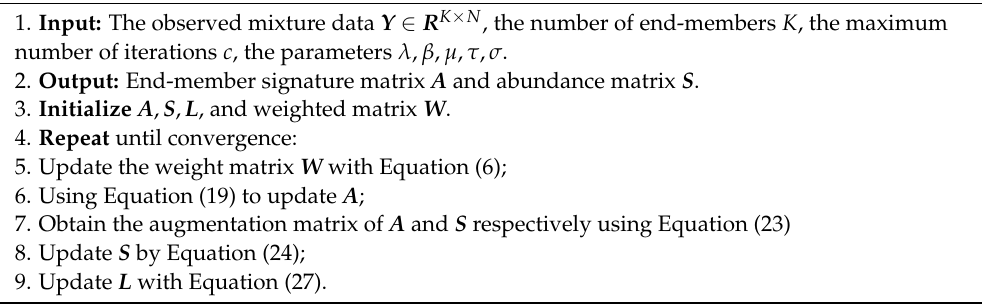
Algorithm 1 Smoothing and Sparse Constraints NMF for